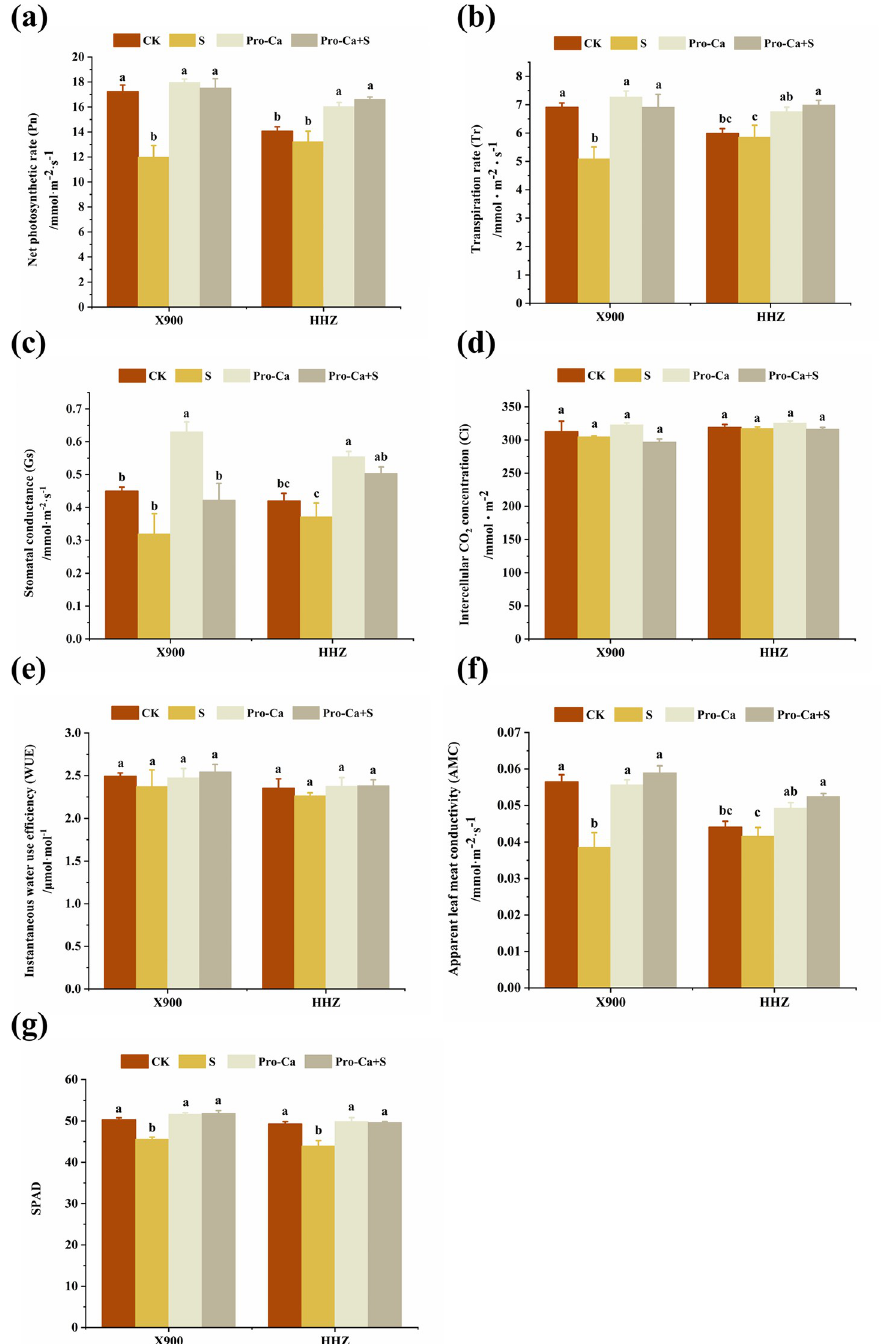
Fig 3. Alleviating effect of exogenous prohexadione-calcium (Pro-Ca) on the photosynthetic capacity of rice under salt stress. a: Net photosynthetic rate (Pn) in the X900 (left) and HHZ (right) plants; b: transpiration rate (Tr) in the X900 (left) and HHZ (right) plants; c: stomatal conductance (Gs) in the X900 (left) and HHZ (right) plants; d: intercellular CO 2 concentration (Ci) in the X900 (left) and HHZ (right) plants; e: instantaneous water use efficiency (WUE) in the X900 (left) and HHZ (right) plants; f: apparent leaf meat conductivity (AMC) in the X900 (left) and HHZ (right) plants; g: SPAD in the X900 (left) and HHZ (right) plants. Abbreviations: CK (water spraying + 0% NaCl), S (water spraying + 0.3% NaCl), Pro-Ca (100 mg � L -1 Pro-Ca leaf spraying + 0.3% NaCl), and Pro-Ca+S (100 mg � L-1 Pro-Ca leaf spraying + 0.3% NaCl). The numerical value represents the mean ± SE ( n = 3), and different lowercase letters indicate significant differences according to Duncan’s test ( p < 0.05).